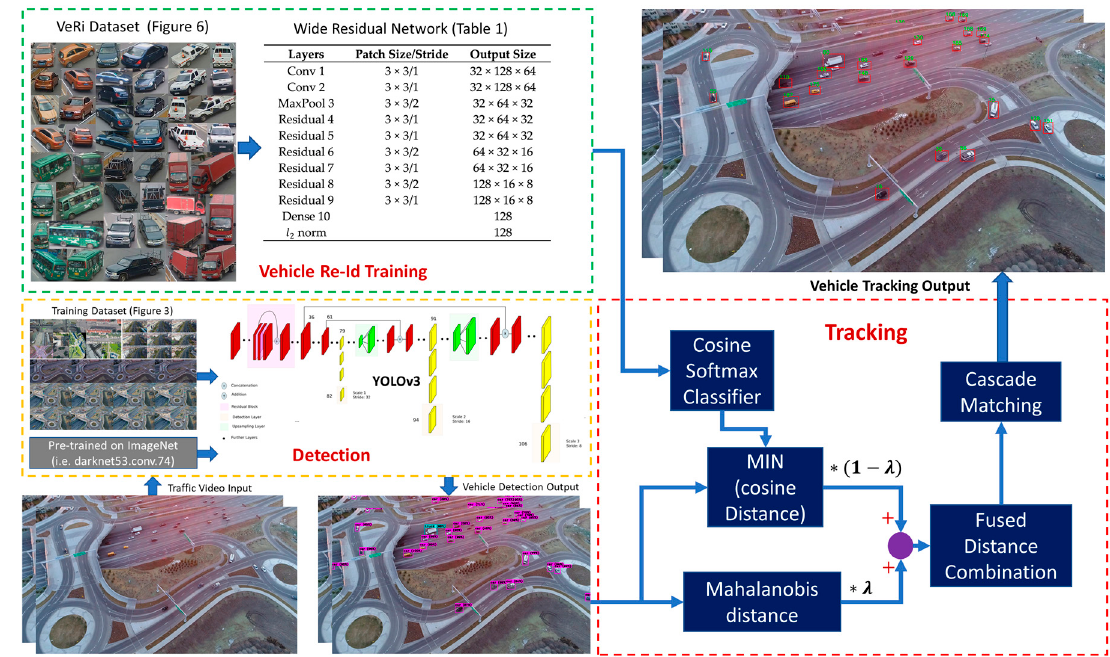
Figure 5. The proposed framework for multiple vehicle tracking-by-detection. Detection: the vehicle detector was fine-tuned on YOLOv3 by a custom labeled dataset together with two other datasets (Figure 4). Re-Id training: deep vehicle Re-Id appearance features were extracted by training a wide residual network (Table 1) with the VeRi dataset (Figure 6). Tracking: the detected bounding boxes were used to calculate the Mahalanobis distance (Equation ( 1)) as the motion metric (Equation (2)),